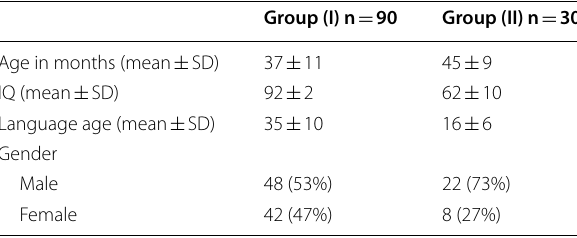
Table 1 The demographic data of the two groups of TD and autistic children with age expressed in